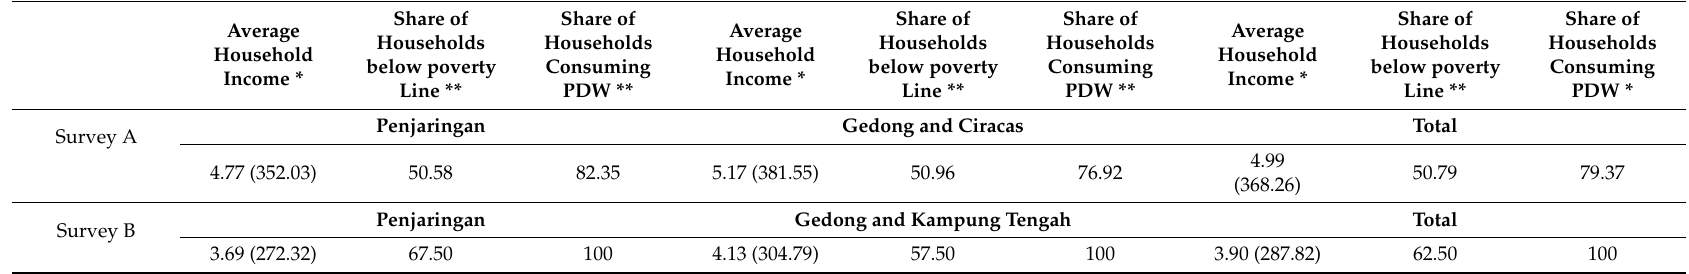
Note: * in million Rupiah (USD) ** in